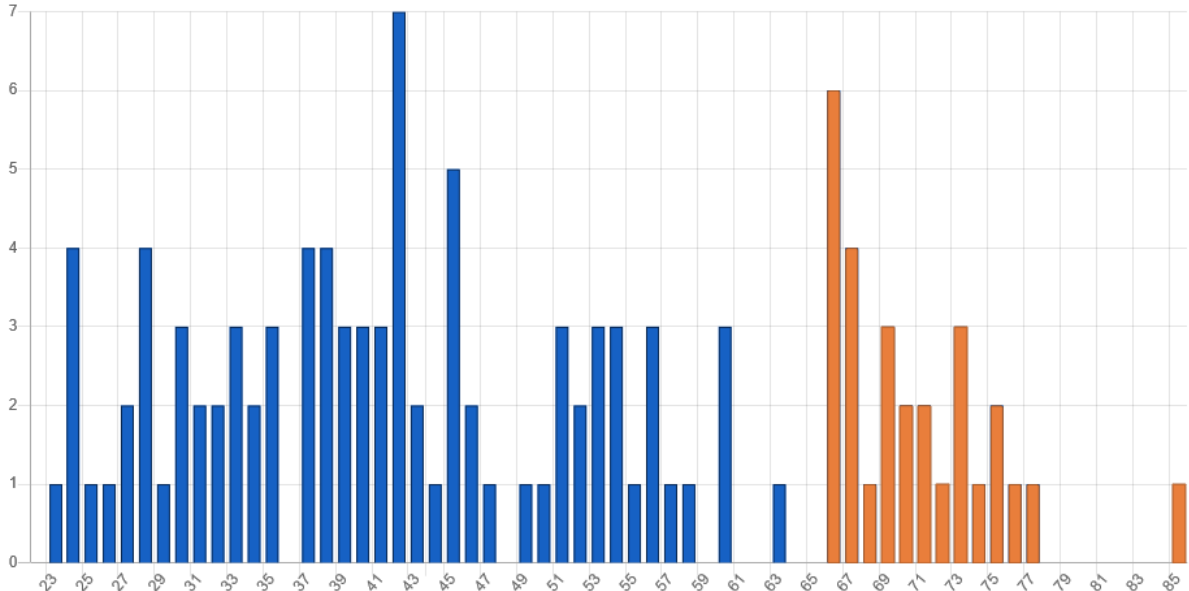
Figure 6. Participants’ age distribution.